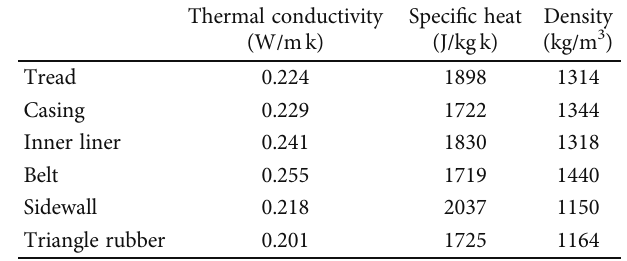
Table 1: Constitutive parameters of the Yeoh model for each rubber